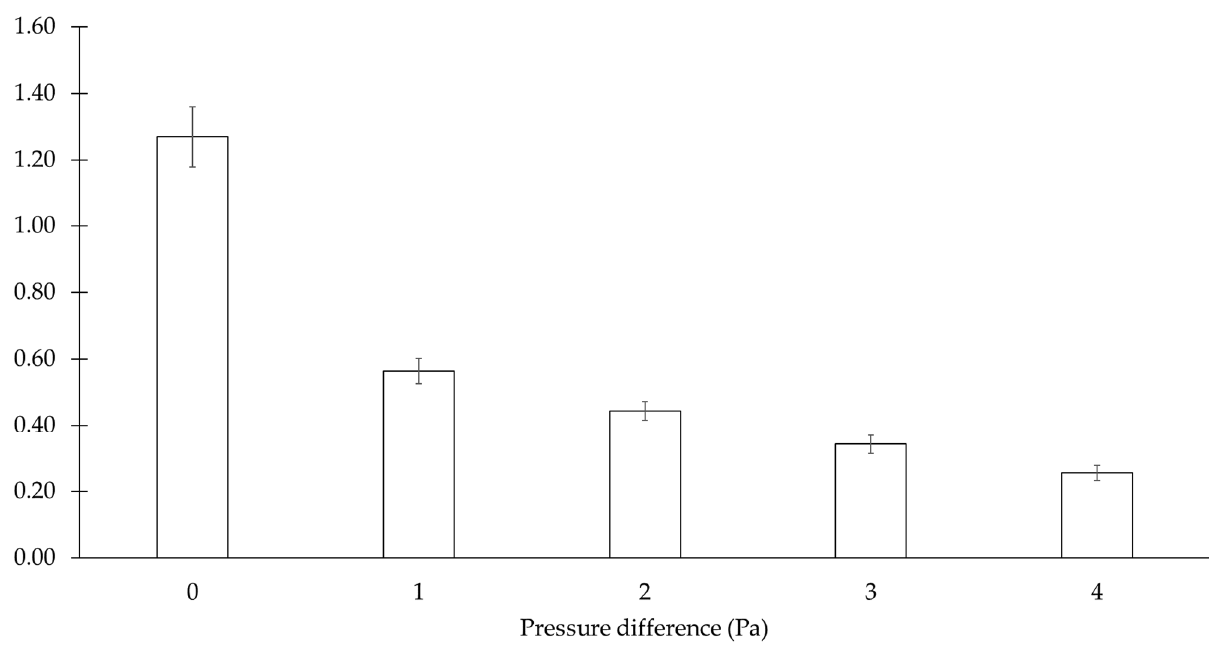
Figure 8. Dust emissions from the plain diffusive transport of ACAM (0 Pa) and from that of ACAM with the oppositely directed convective flow (means ± SD, n = 3). For information on the simulated and measured average air velocity, refer to Table 3.